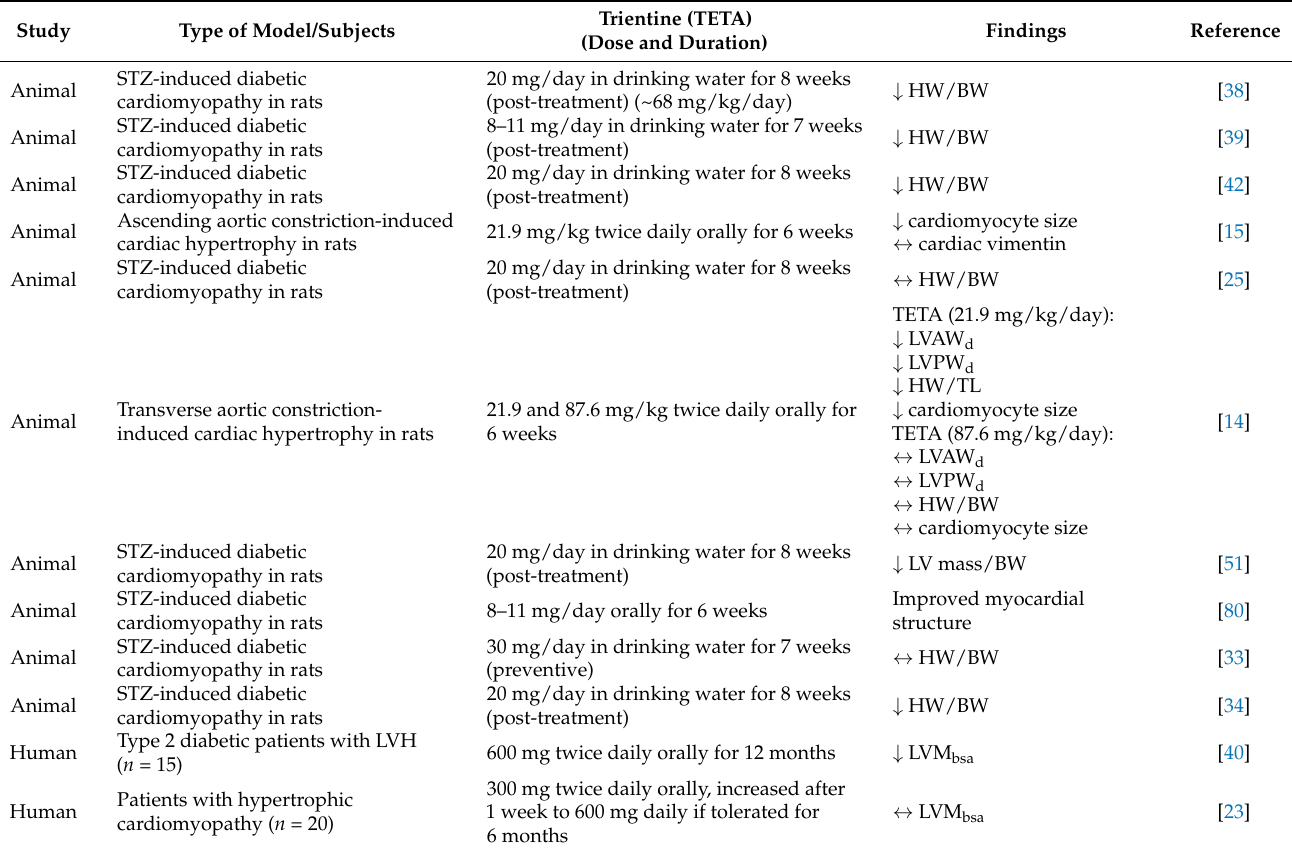
Table 6. Effects trientine on cardiac structure/hypertrophy in human and animal